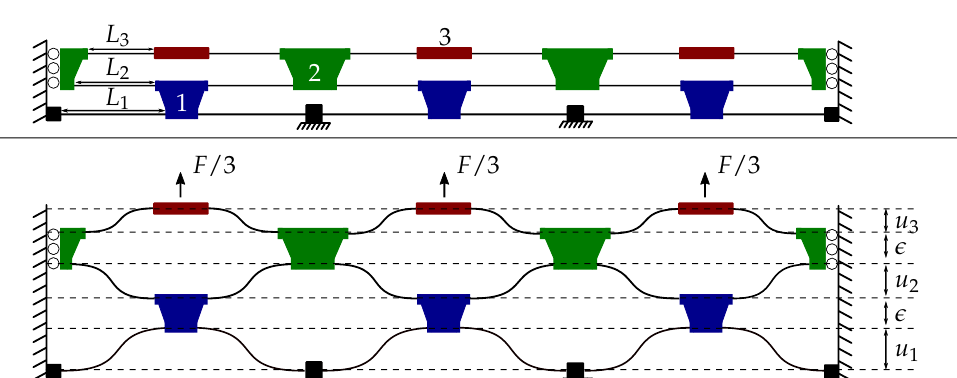
Figure A2. Sketch representing the unfolded ortho-planar springs. This 2D hyper-guided structure is assumed to be equivalent to one 3D ortho-planar spring under the assumption of a purely vertical motion (i.e., no radial displacement within the 3D structure). Tables 1, 2, 3 are the junctions between the beams. The hyper-guided system is presented at rest ( top ), and under a vertical force F ( bottom